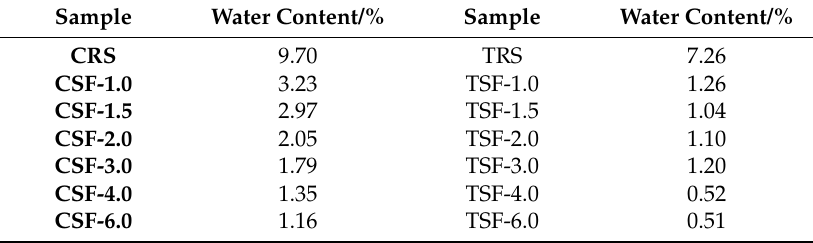
Table 2 compared E (cid:48) and tan δ of these two kinds of regenerated silk fibers (CRS and TRS)